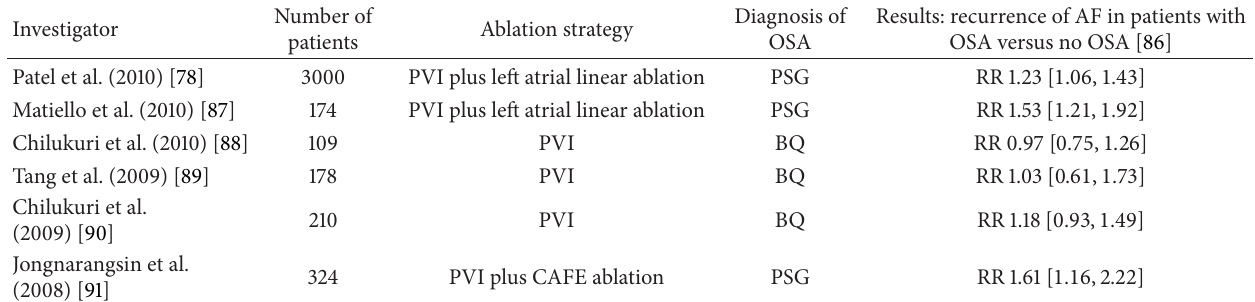
Table 4: Risk of AF recurrence after catheter